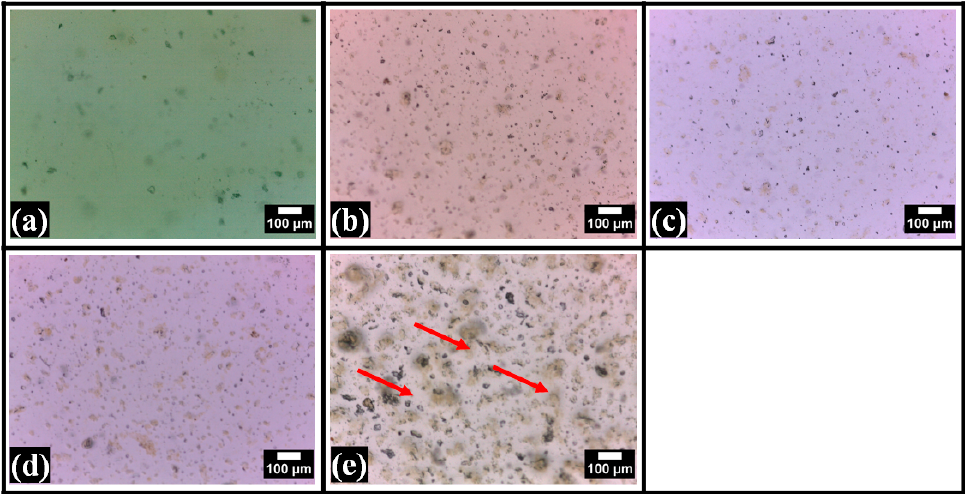
Figure 2. Bright-field micrographs of the films: ( a ) F0, ( b ) F1, ( c ) F2, ( d ) F3, and ( e ) F4.